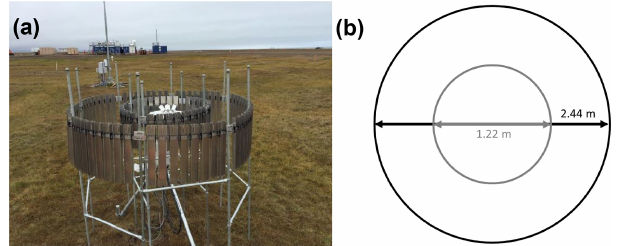
Figure 2. (a) The MASC was relocated to ground level and placed inside a Belfort double Alter shield on 22 August 2016 (field site photograph courtesy of Martin Stuefer). (b) The shield consists of inner and outer fences with diameters of 1.22 and 2.44m, respec-